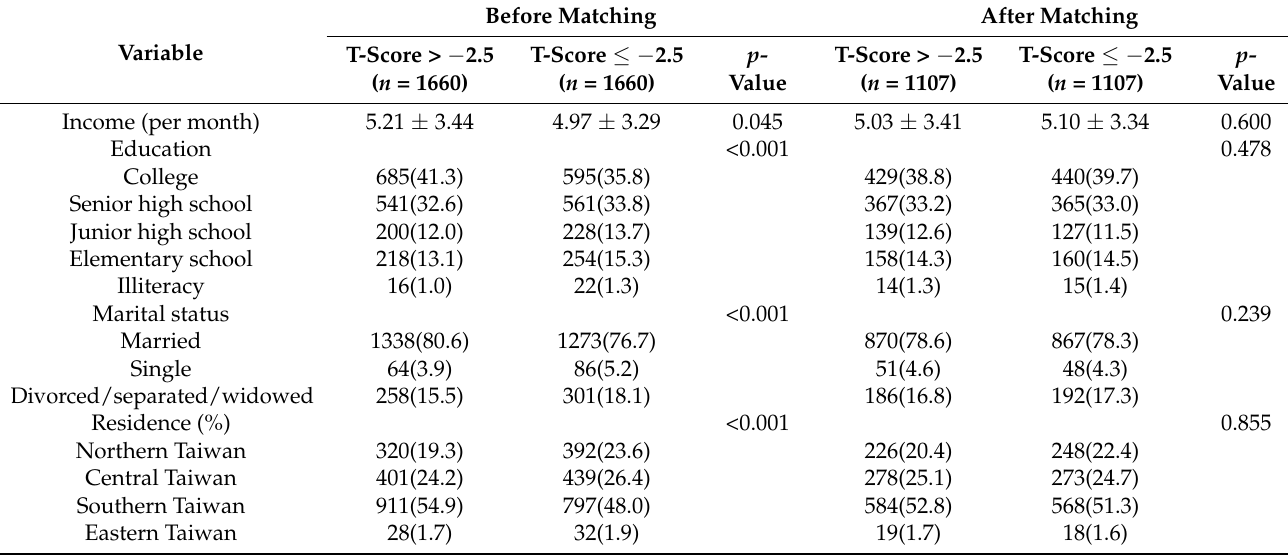
Table 3. Socioeconomic, residency, and educational status.